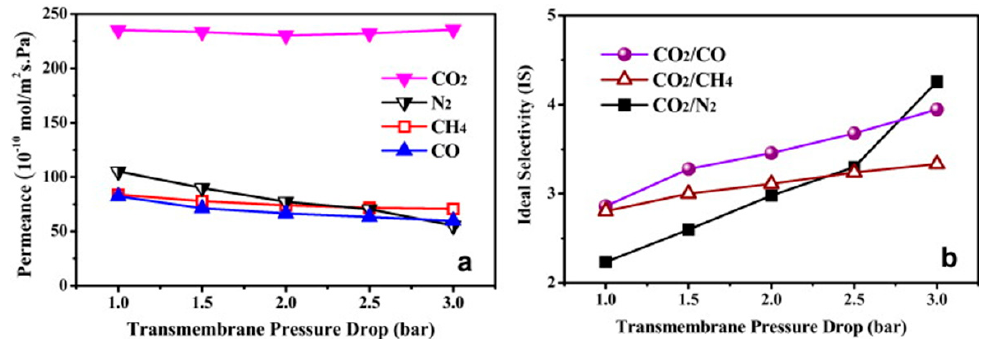
Figure 50. ( a ) Single gas permeances of CO 2 , N 2 , CH 4 , and CO through a ZIF-69 membrane as a function of transmembrane pressure drop at 298 K. ( b ) The ideal selectivities of CO 2 /CO, CO 2 /CH 4 , and CO 2 /N 2 for a ZIF-69 membrane as a function of transmembrane pressure drop at 298 K (adapted with permission from ref. [147]).